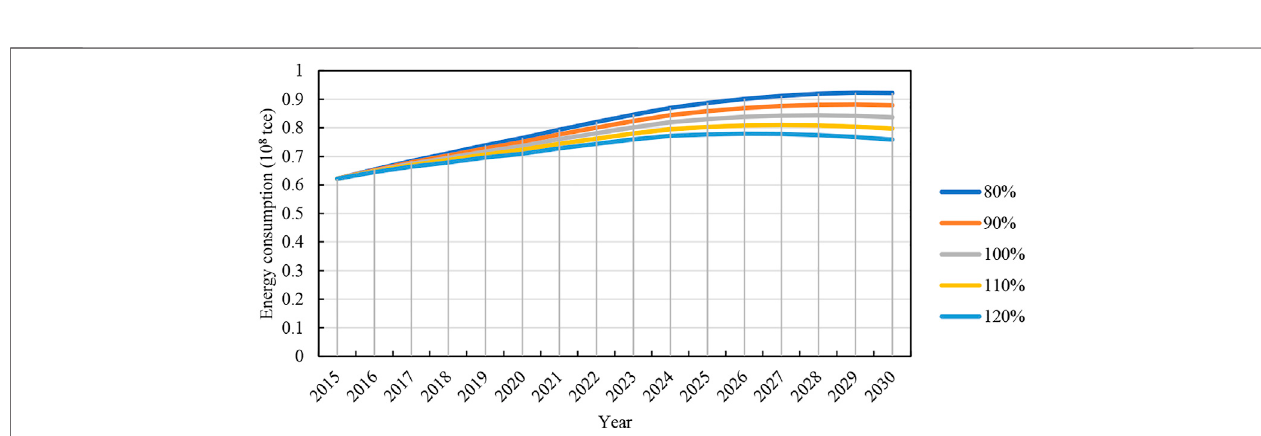
FIGURE 10 | CO 2 emissions under different degrees of implementation of reduction measures in Guangdong Province.